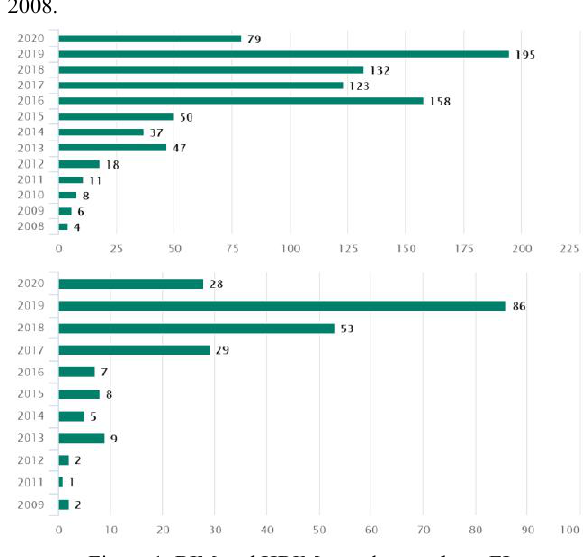
Figure 1. BIM and HBIM search records on EI (https://www.engineeringvillage.com/search/expert.url?SEARC HID=e114088315404b659c87ca0e0a315c47&COUNT=1&usa geOrigin=&usageZone=)